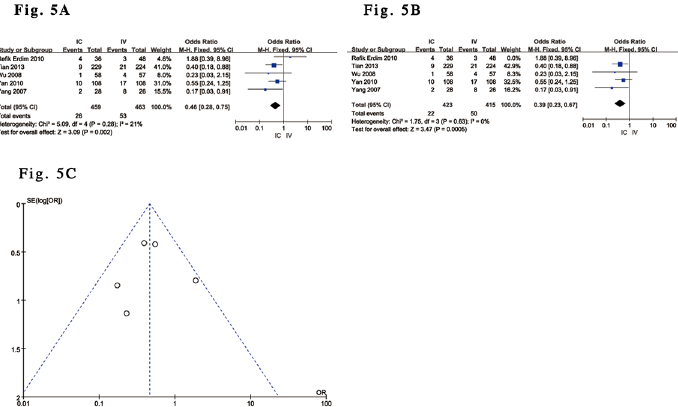
Fig 5. Forest plot of MACE in ACS patients with IC vs. IV administration of tirofiban. (A). Forest plot for total MACE based on a fixed-effects model in ACS patients with IC vs. IV administration of tirofiban. (B). Forest plot for MACE based on a fixed-effects model excluding one retrospective trial in ACS patients with IC vs. IV administration of tirofiban. (C). Funnel plot of MACE used to identify evidence of publication bias.